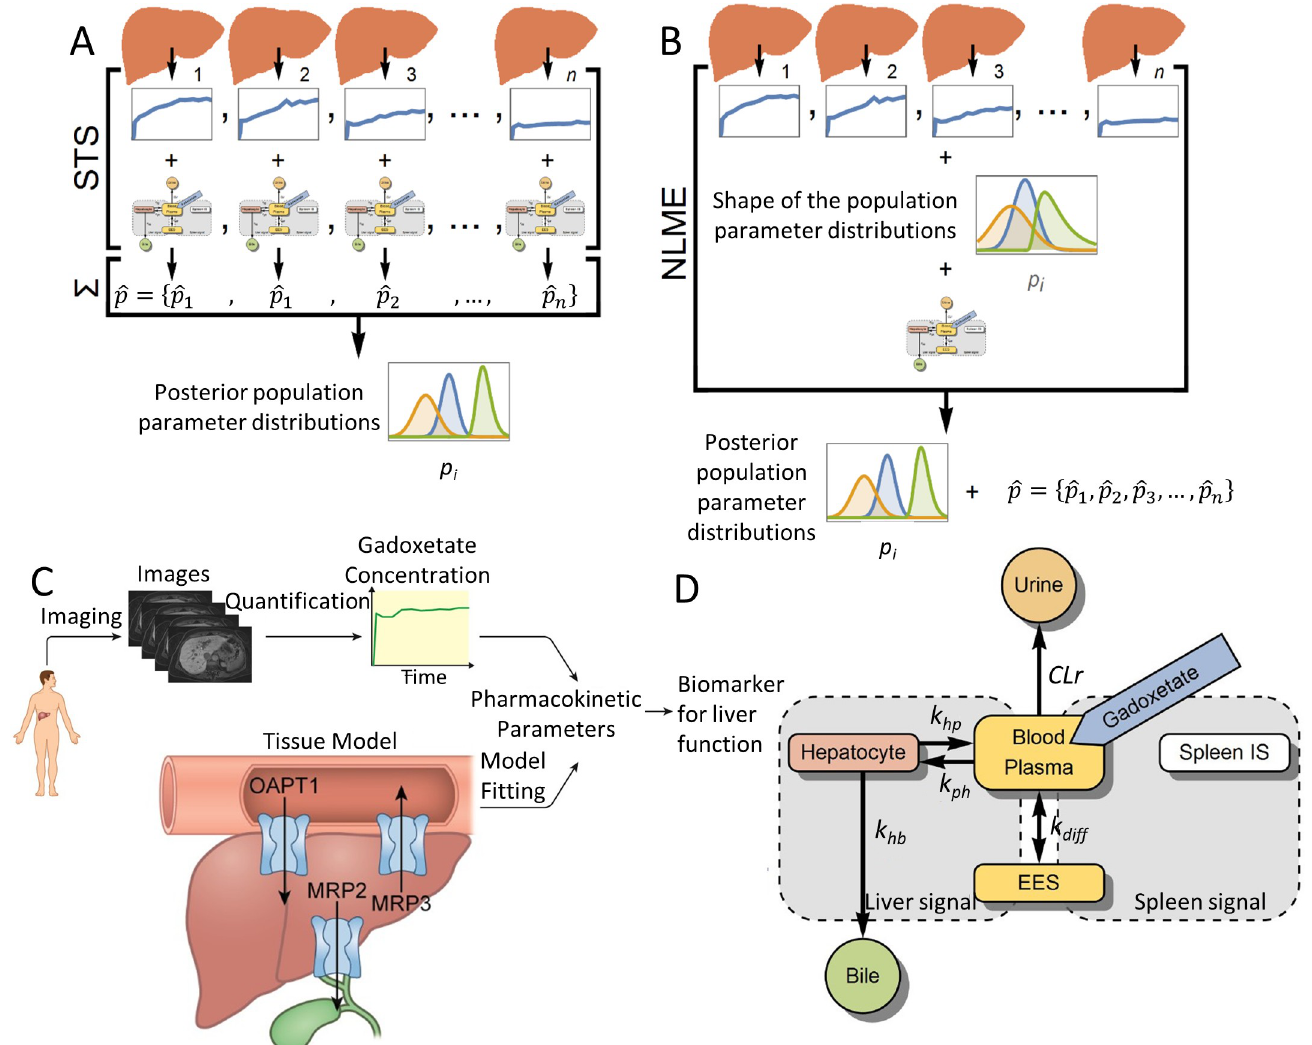
Fig 1. NLME, the mechanistic model framework, and model. ( A ) The standard-two-stage (STS) method. The model is parametrized for each data set separately, and then the parameter values are combined to derive population parameter distributions. ( B ) The ‘non-linear mixed effect’ (NLME) method. The shapes of the population parameter distributions are first postulated, then distributions are parametrized to all datasets, and finally each patient is parametrized following the population parameter distributions with a joint-likelihood function. This allows NLME to use the global information obtained from an entire cohort, which is utilized to improve model parametrization for each individual subject. ( C ) The framework consists of gadoxetate-enhanced images, which are processed to obtain gadoxetate concentrations in the liver. A mechanistic systems pharmacology model, describing how gadoxetate is taken up and excreted, is fitted to the data using NLME parameterization to obtain reliable pharmacokinetic parameters, which can be used as biomarkers for liver function. ( D) Schematic diagram of the mechanistic model for quantification of liver transporter function. Rounded rectangles represent compartments in the model, with arrows indicating gadoxetate fluxes between blood plasma and extracellular extravascular space (EES; k diff ), elimination via the kidneys to urine (CLr), uptake into hepatocytes (k ph ), back-flux from hepatocytes into blood plasma (k hp ), and excretion from hepatocytes into bile (k hb ). Gadoxetate injection into the blood-plasma compartment is indicated in blue. Gray areas show the signal part of the model in which compartmental gadoxetate concentrations are combined to predict the information in the gadoxetate- enhanced MRI time series.